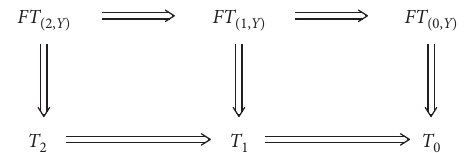
Figure 1: The relationships between functionally separation ax- ioms and classical separation